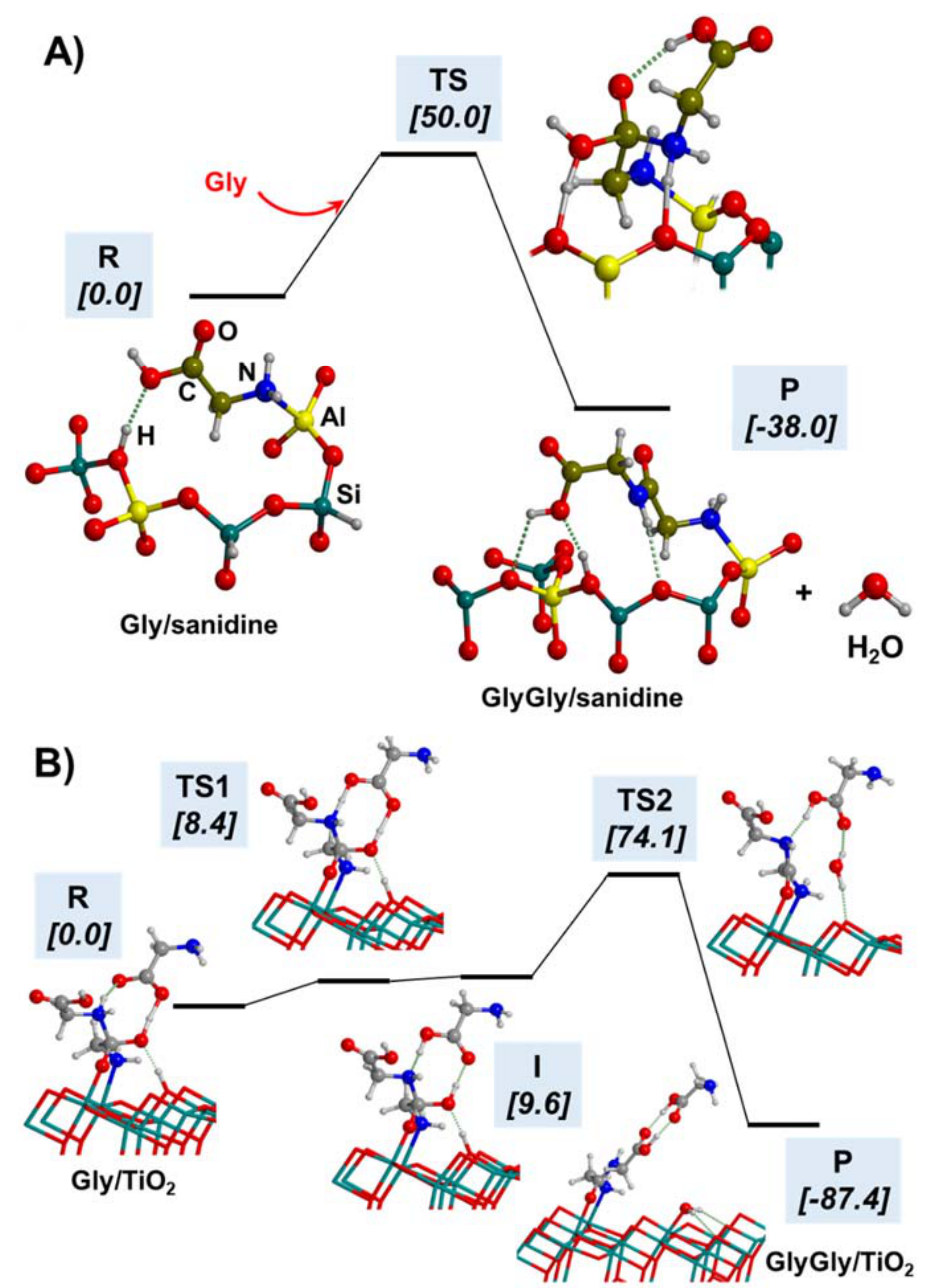
Figure 9. Free energy profiles at 298 K (in kJ mol − 1 ) for the condensation reactions between two Gly molecules on a sanidine surface cluster model ( A , adapted from Refs. [158,159]) and on the anatase (101) TiO 2 surface model ( B , adapted from Ref. [207]), with this latter case occurring in the presence of a third Gly molecule that catalyses the processes. R means the reactants, TS the transition states, P the products, and I the intermediate.